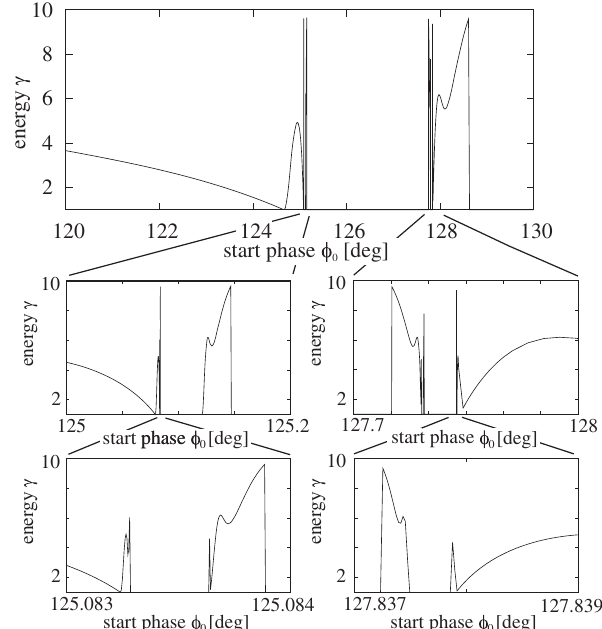
FIG. 6. Energy of electrons leaving a 1 1 start phases between 120° and 130°. Self-similar structures reveal a chaotic behavior of the electron